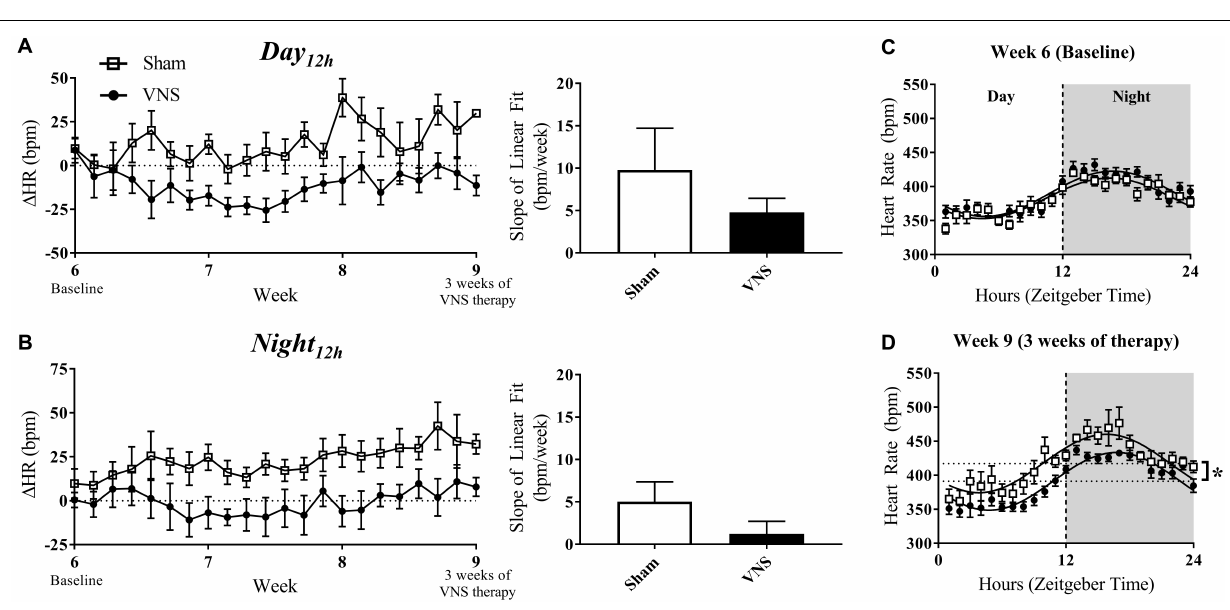
Figures 4A,B (left panel) quantifies the relative change in HR over time during the Day 12h and Night 12h intervals in the Sham and VNS rats. The slopes of the (cid:49) HR linear regression, although lower in VNS rats, were not significantly different during either interval ( Figures 4A,B , right panel).